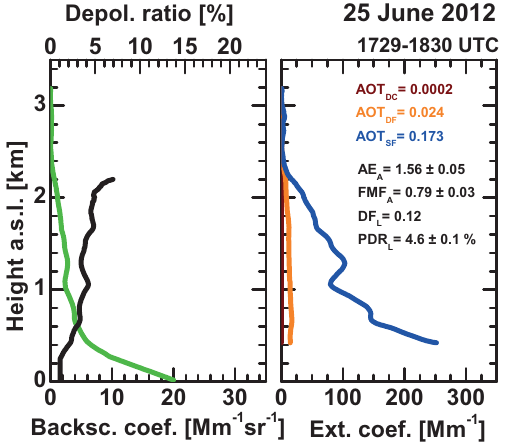
Figure 11. Same as Fig. 10, except for 25 June 2012.